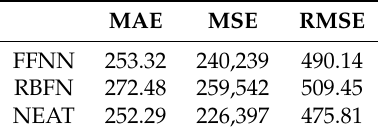
Table 5. Error measures of predictions by considering three different neural